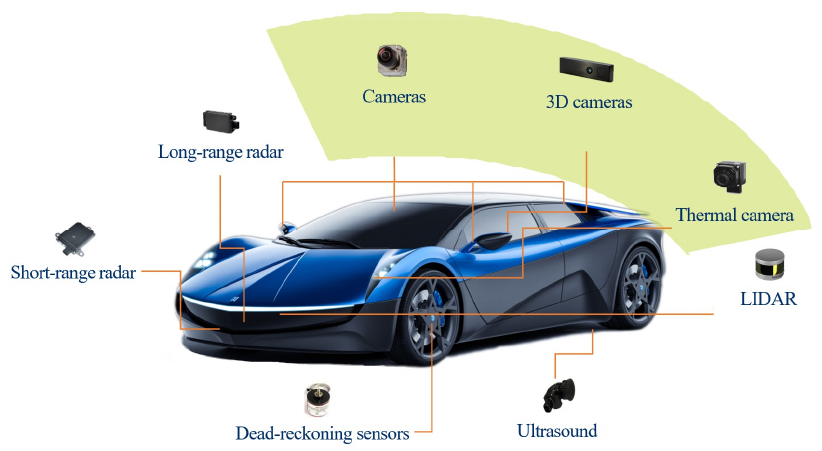
Figure 1. Image devices used in ADAS for automotive application.